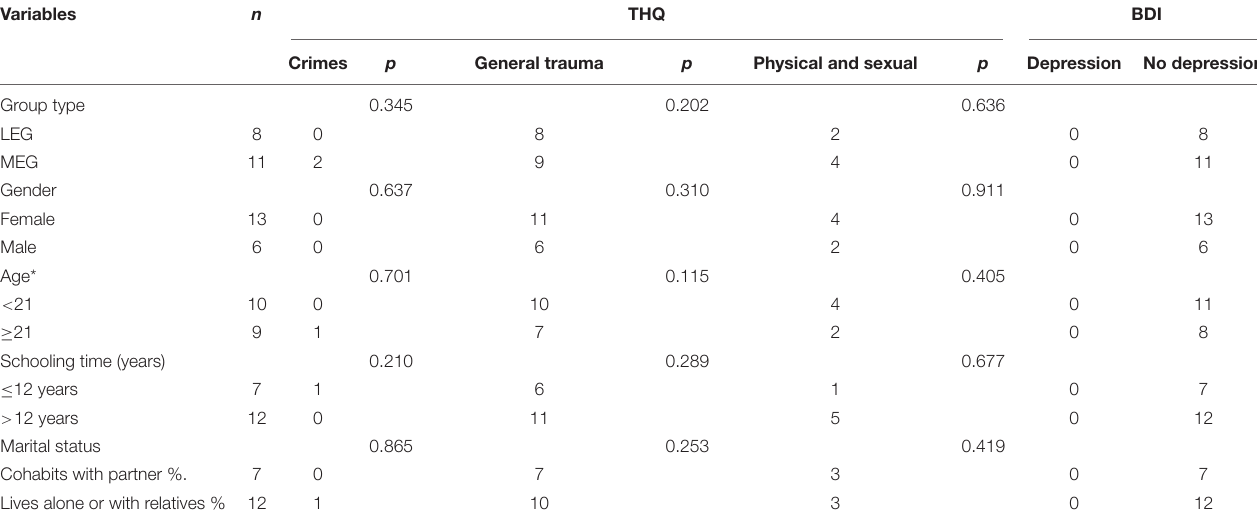
*Early age of perception of